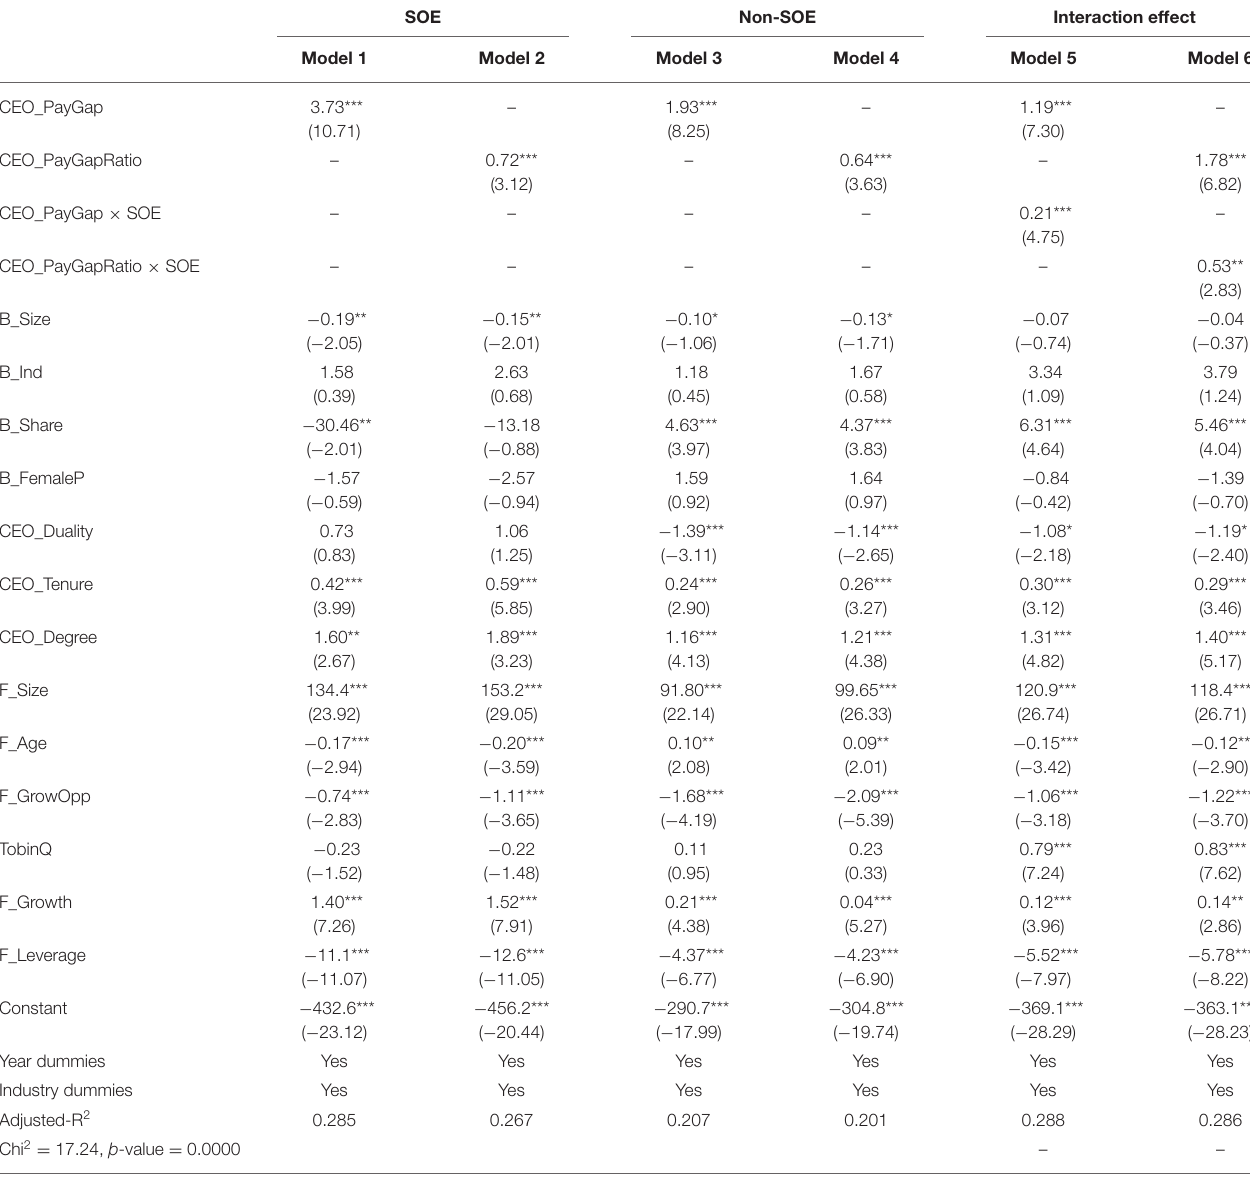
TABLE 2 | CEO tournament incentive and corporate social responsibility performance (sub-sample SOEs vs. non-SOEs) and interaction